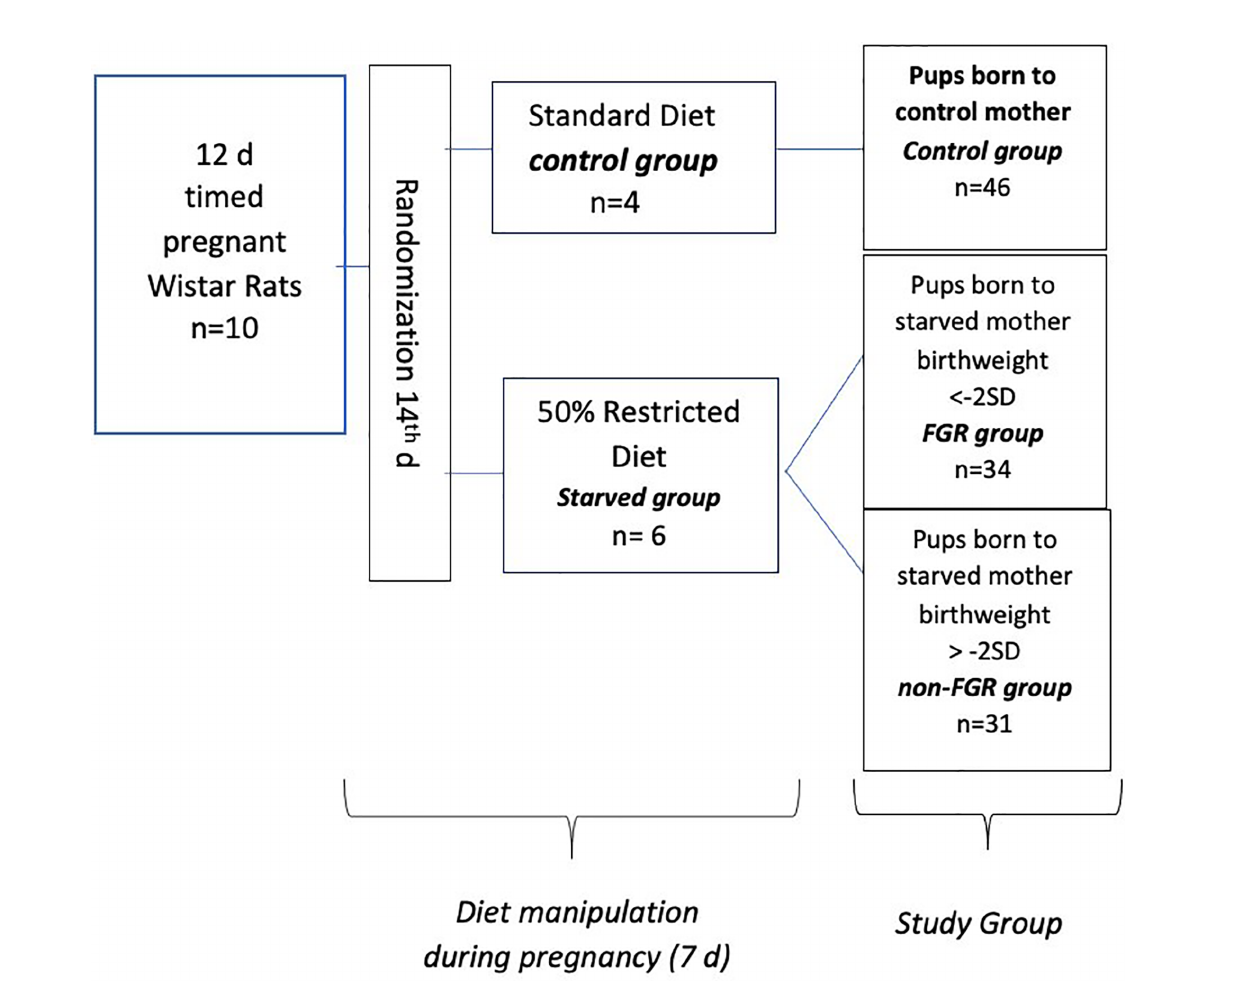
FIGURE 1 | Experimental design of the